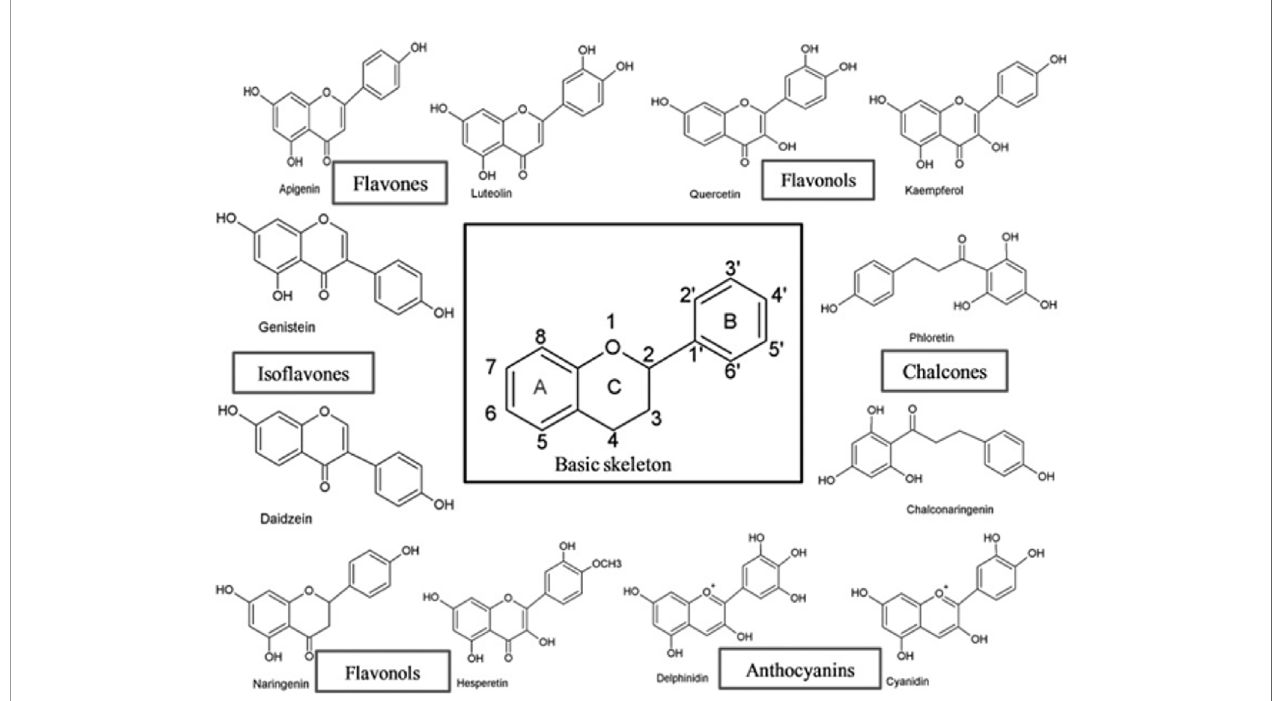
FIGURE 1 | The basic skeleton structure of fl avonoids and six major classes of fl avonoids